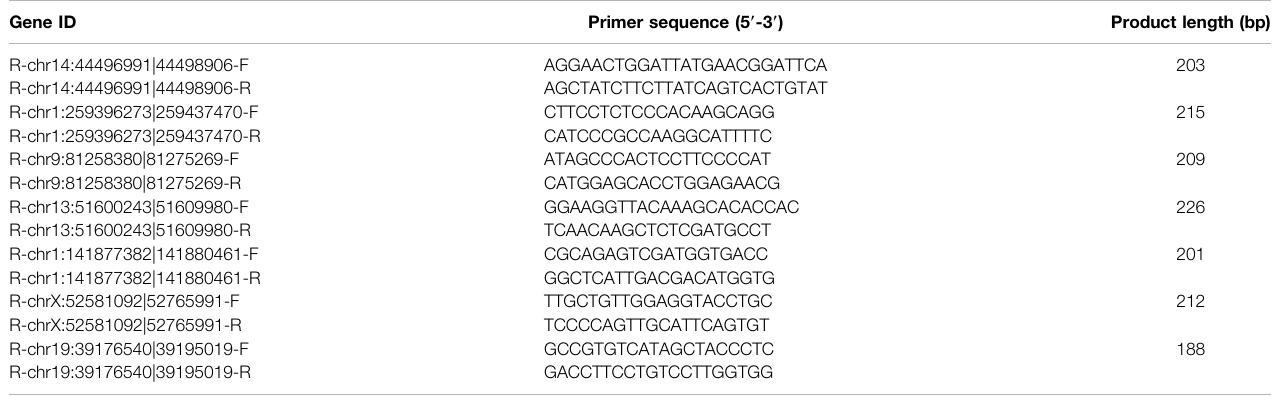
TABLE 1 | The information of primers used for quantitative PCR